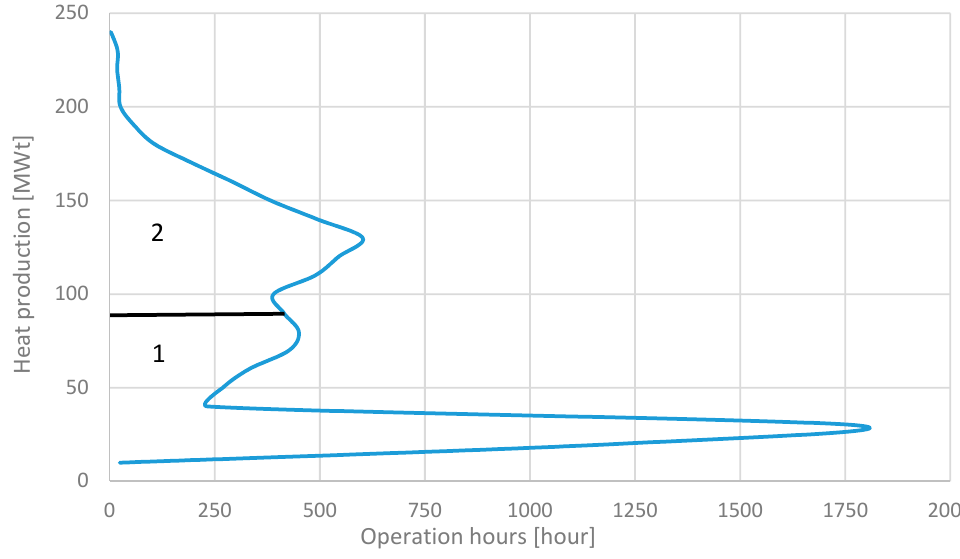
Figure 5. Limitation of the bigger CT at the produced heat power by the CPP in 2016 [5].